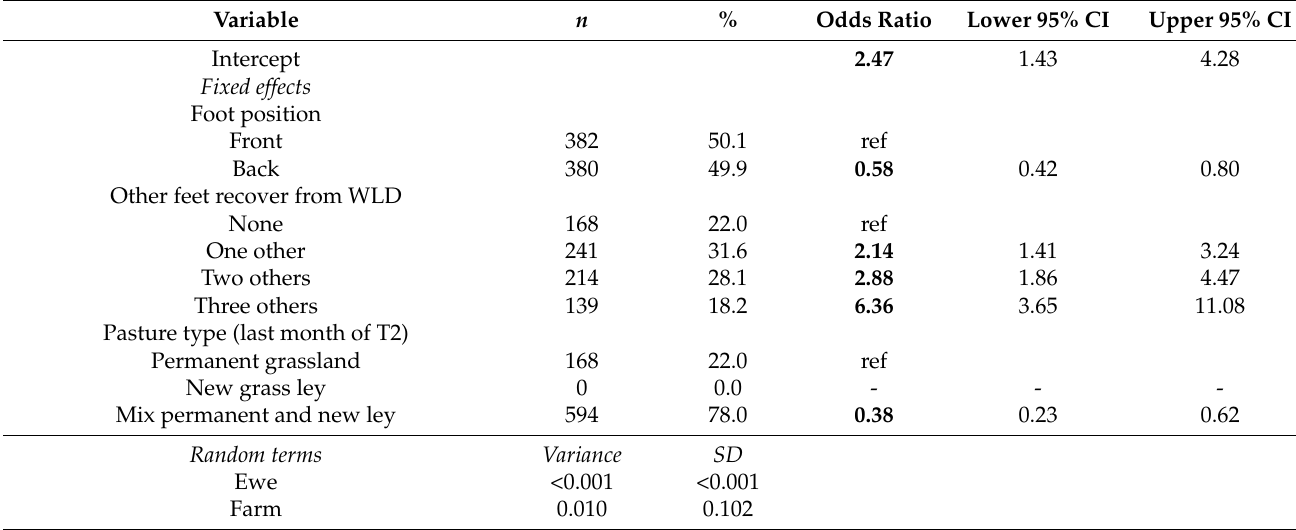
Table 14. Final multivariable model of the associations with the recovery from WLD at foot-level for 762 observations of